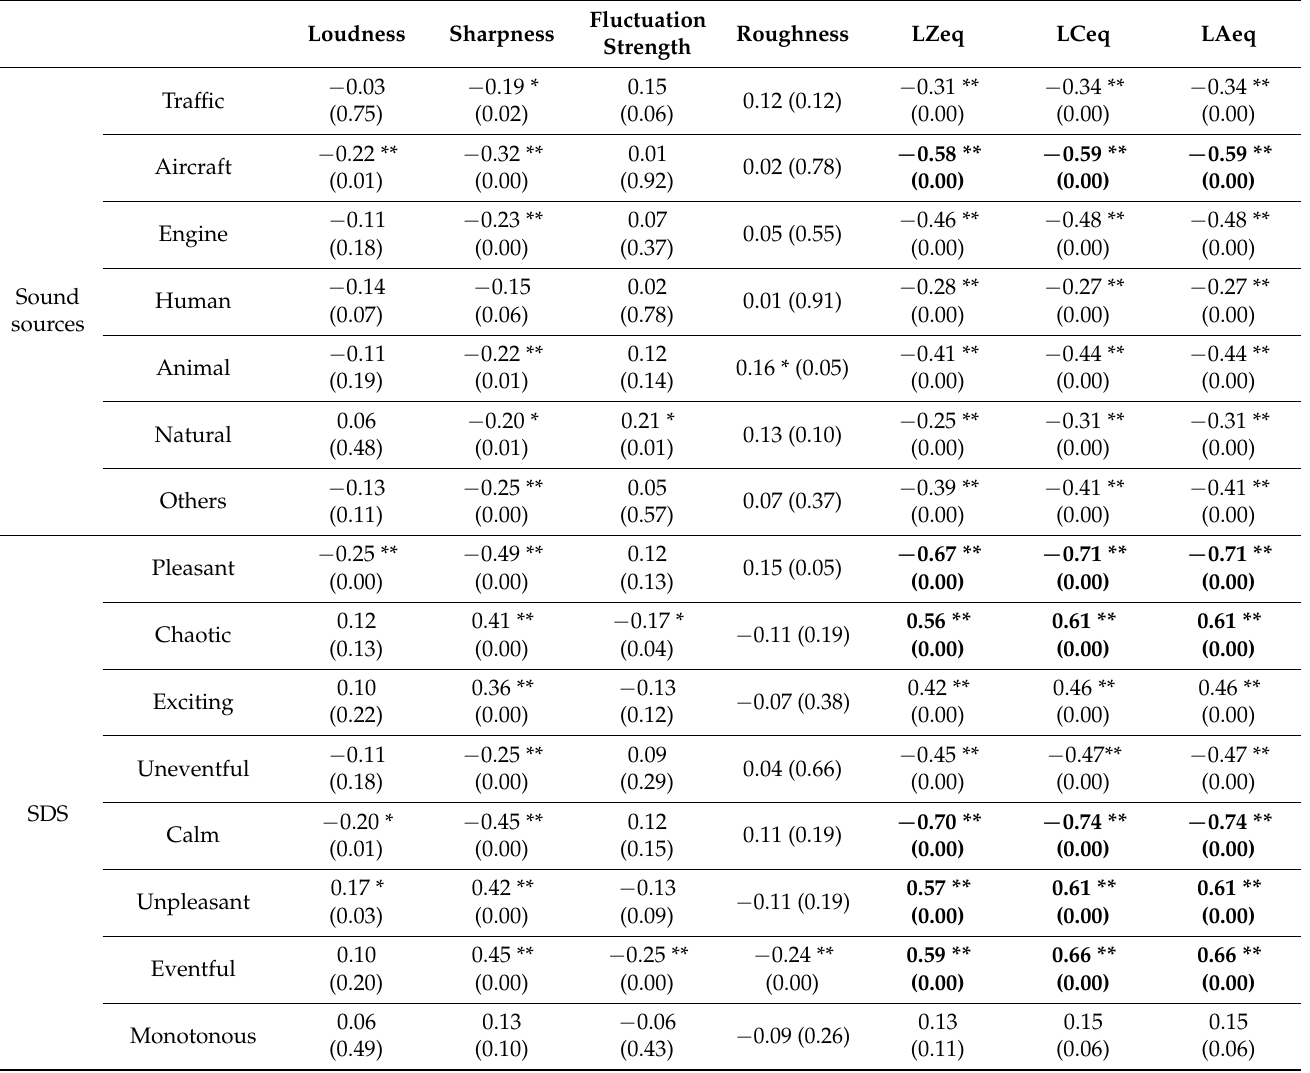
Table 5. Spearman’s correlation coefficients between the subjective ratings on the acoustic envi- ronment (sound sources, SDS, soundscape appropriateness, landscape quality, and frequency of visits) and the objective acoustic parameters (Leq, LAeq, LCeq, Loudness, Sharpness, Roughness, and Fluctuation Strength). The p -values are in parentheses. Large association between variables according to Cohen’s criterion, is marked in bold. * The correlation is significant at the 0.05 level. ** The correlation is significant at the 0.01